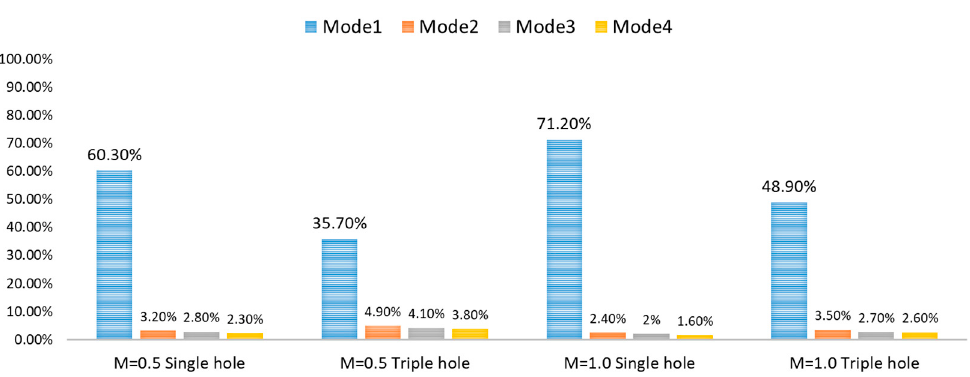
Figure 17. Portions of the total kinetic energy for Mode 1, 2, 3, and 4 in the plane of x/D = 2.